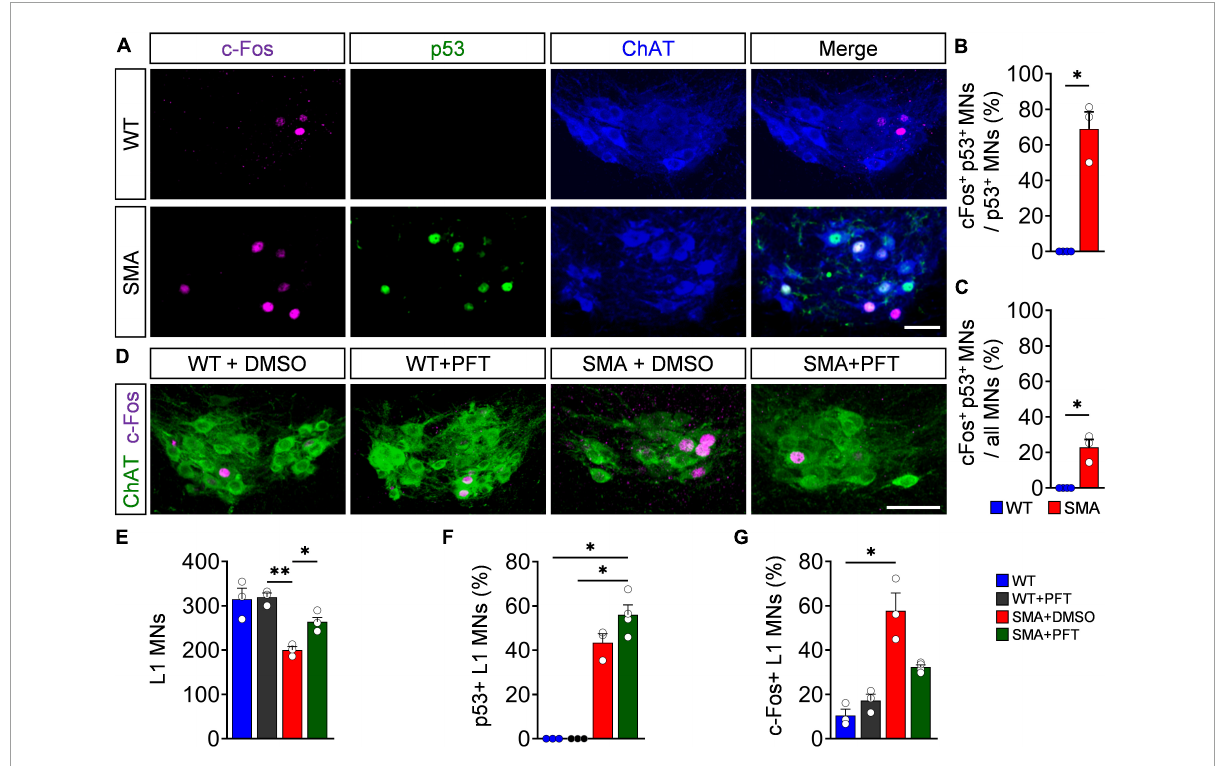
FIGURE2 p53 drives c-Fos upregulation in spinal muscular atrophy (SMA) motor neurons. (A) Immunostaining of c-Fos (magenta), p53 (green), and ChAT + (blue) motor neurons (MNs) of L1 spinal segments from P4 control wild-type (WT) and SMN (cid:49) 7 mutant (SMA) mice. Scale bar = 50 µ m. Quantification of MNs coexpressing both c-Fos and p53 in comparison to p53 positive MNs (B) or (C) all MNs in% from the same groups as in panel (A) . n = 3 per genotype. (D) Immunostaining of c-Fos (magenta) and L1 ChAT + motor neurons (green) of spinal cords from P4 WT and SMA animals treated chronically with DMSO or Pifithrin- α (PFT). Scale bar = 50 µ m. Number of L1 MNs (E) , percentage of p53 (F) , and c-Fos positive (G) MNs. n = 3–4 per genotype. Statistics: Mann–Whitney test for panels (B,C) , Kruskal–Wallis test for panel (F) and one-way ANOVA with Tukey’s correction for panels (E,G) . Each data point (n) represents one animal. Asterisks on top of bars without horizontal line indicate the significance compared to another group. * p < 0.05; ** p <